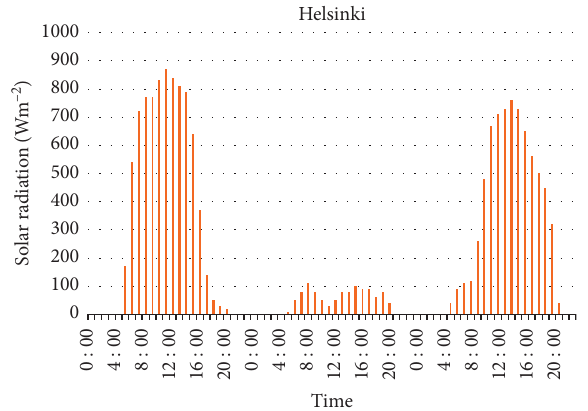
Figure 9: Solar radiation values in